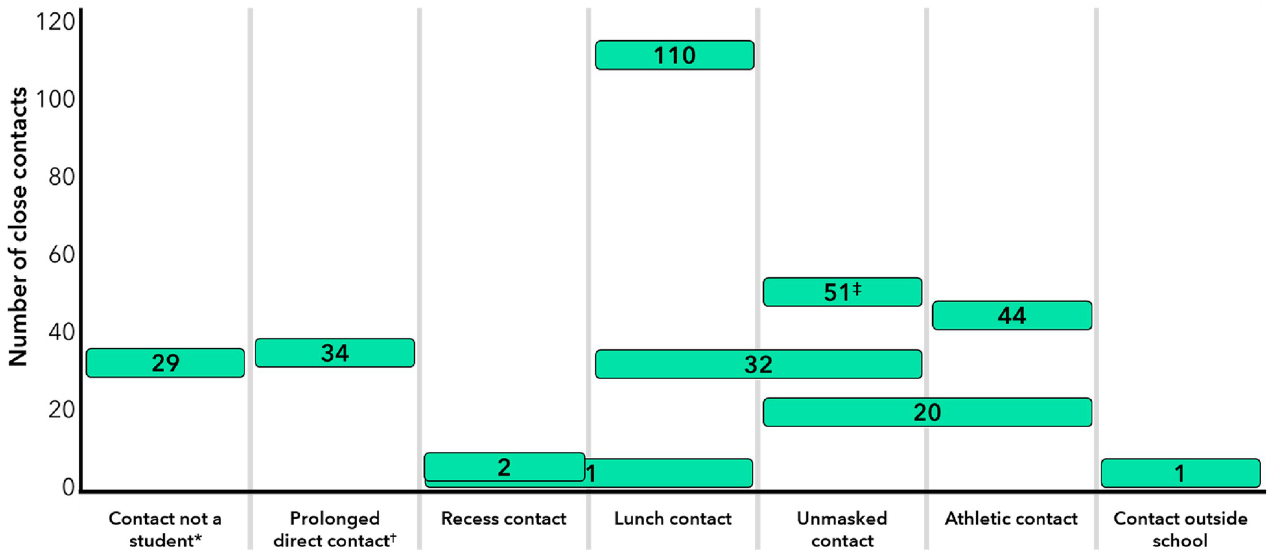
Fig 1. Primary reasons close contacts of persons with COVID-19 (n = 345) were deemed ineligible for modified quarantine by K–12 school officials, Greene County, Missouri, January 25–March 21, 2021. Abbreviations: COVID-19 = coronavirus disease 2019; K–12 = kindergarten through grade 12. The number inside a rectangle corresponds to the number of close contacts who were deemed ineligible for a modified quarantine based on the category below the rectangle. Rectangles that overlap two reasons indicate both reasons were cited in the decision to deem the individual ineligible for a modified quarantine. � Under Greene County’s modified quarantine policy, only students aged � 18 years were eligible for a modified quarantine. † Prolonged direct contact was defined as direct physical contact with the person having COVID-19 for � 15 minutes. ‡ Includes 7 contacts who were also ineligible due to extracurricular activities and 2 contacts who were also ineligible due to contact outside of